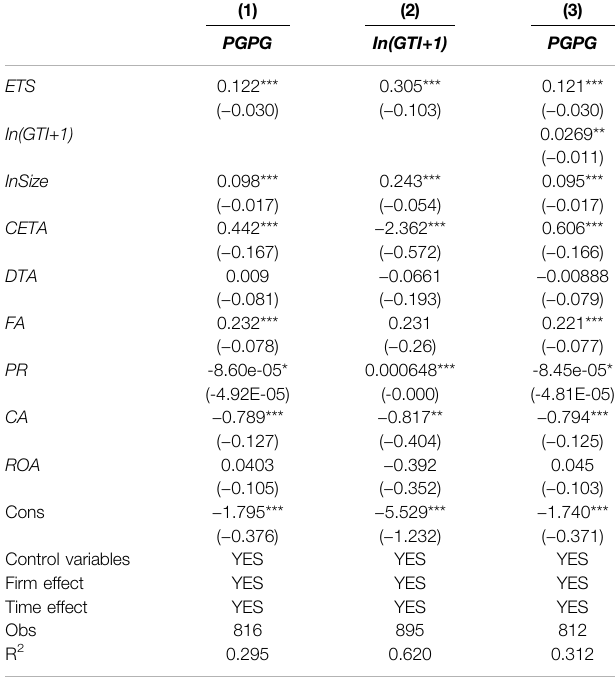
TABLE 6 | The results of the mechanical test.